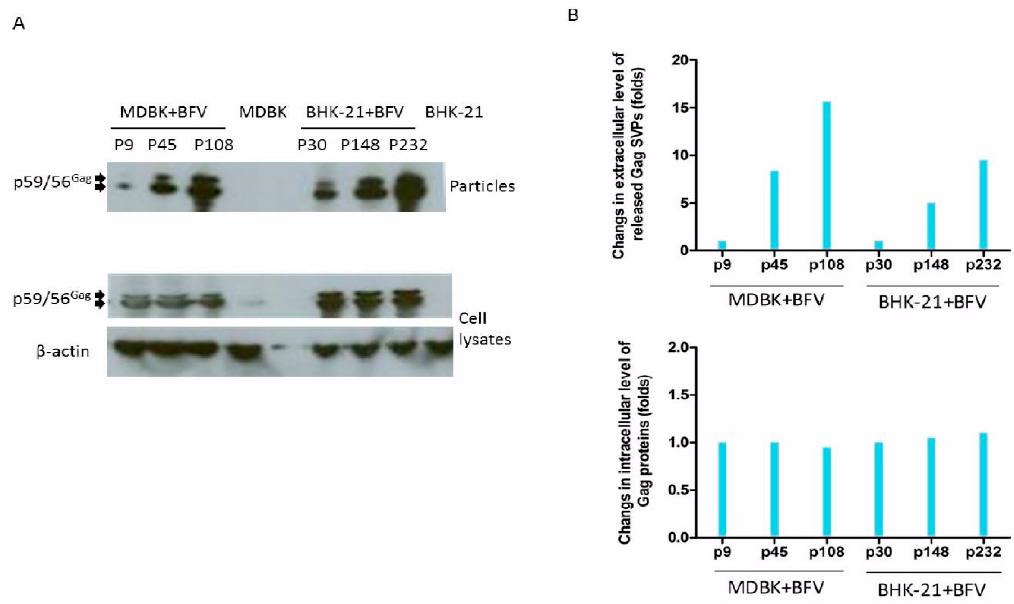
Figure 6. Enhanced budding of late-passage BFV as determined by immunoblotting. ( A ) Cells and supernatants (bottom and top panels) were harvested at the indicated passages for immunoblotting (BFV-infected MDBK cells: p9, p45 and p108; BFV-infected BHK-21 cells: p30, p148 and p232). The Gag precursor (p59) and cleaved form (p56) are marked by arrows. ( B ) Densitometric quantification of relative Gag expression levels (bottom) and budding capacities (top) of BFV from different passages and cell lines as indicated. ImageJ was used for densitometric analysis to quantify the density of the immunoblot bands. The results from the loading controls ( β -actin) were used to scale the values of the protein of interest (Gag). Densitometric data of the middle and late passages were normalized to the corresponding values of early passages (p9 and p30, respectively) showing similar intracellular Gag expression levels (bottom panel) but an increased budding capacity with continued selection (top panel).